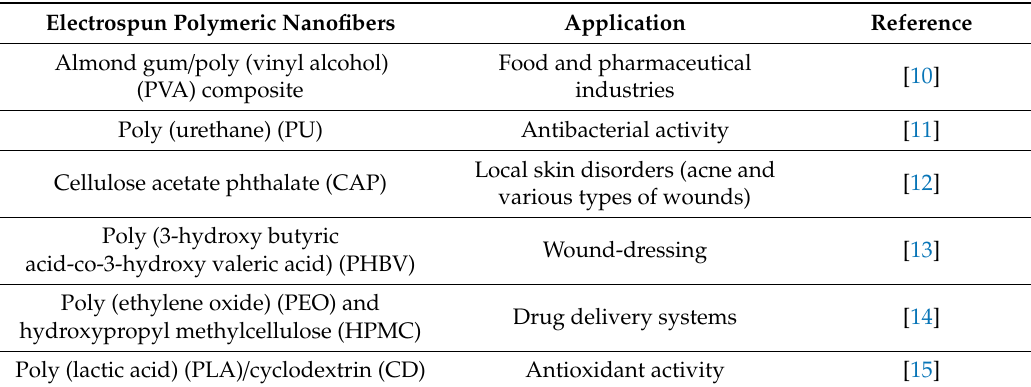
Table 1. Electrospun polymeric nanofibers loaded with